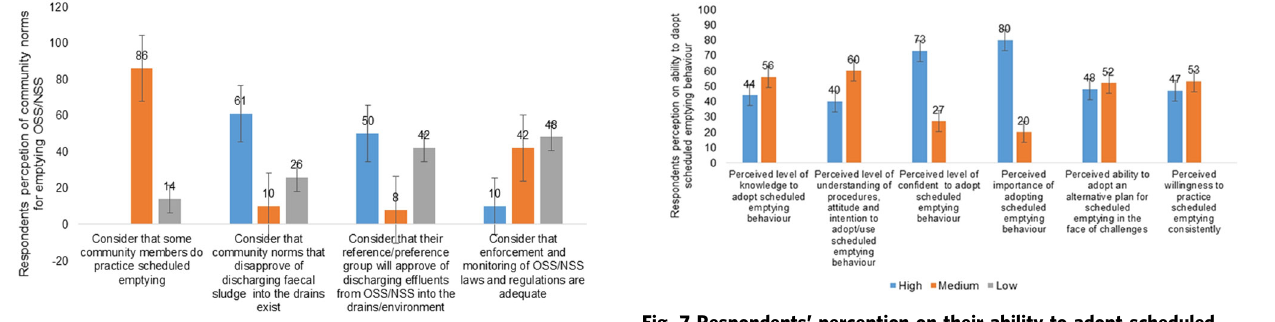
timely and safe) emptying behaviour was high (80%) and medium (20%); perceived own household ability to adapt alternate plans for scheduled